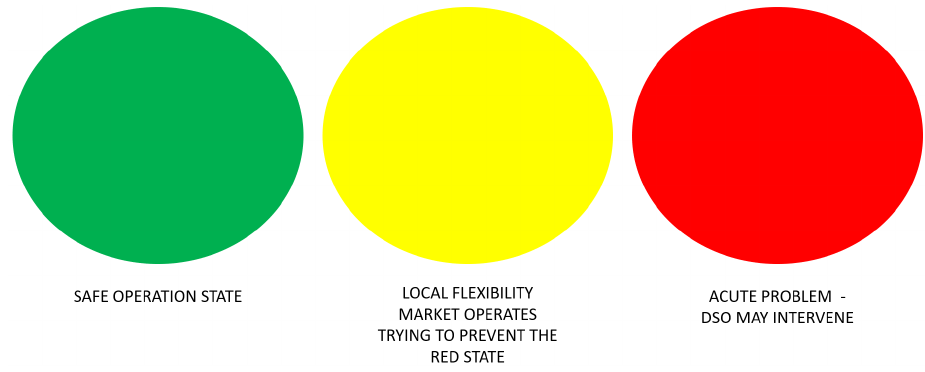
Figure 2. Traffic Light